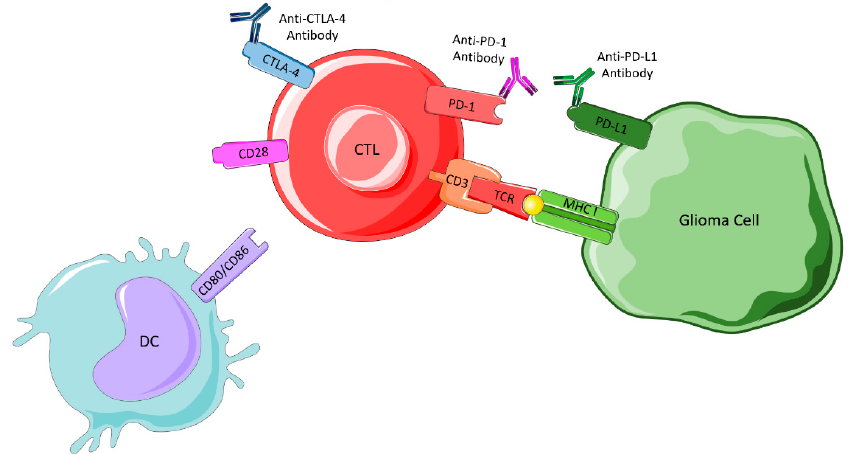
Figure 7. Immune checkpoint blockade. Figure drawn with smart.servier.com.